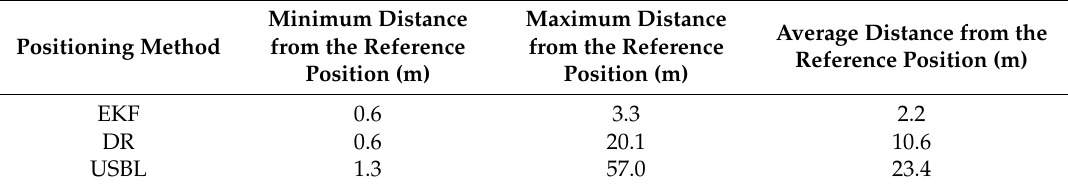
Table 4. The statistical parameters of the positioning errors using EKF, DR methods and the USBL system (one hundred system (one hundred passages).